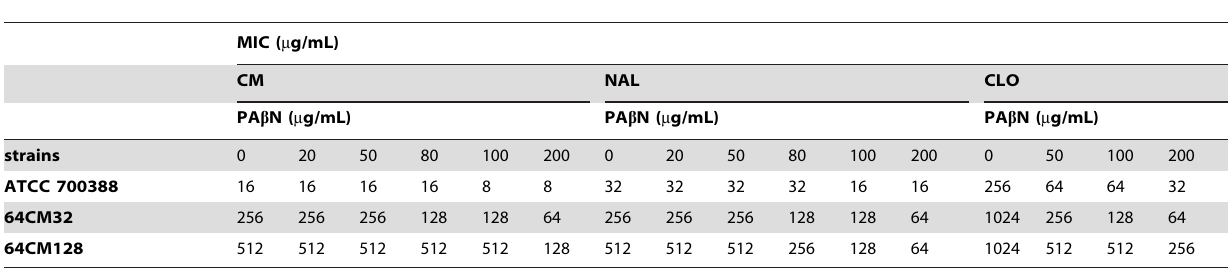
Table 2. Effects of PA b N on antibiotic susceptibility of the B. thailandensis strains.